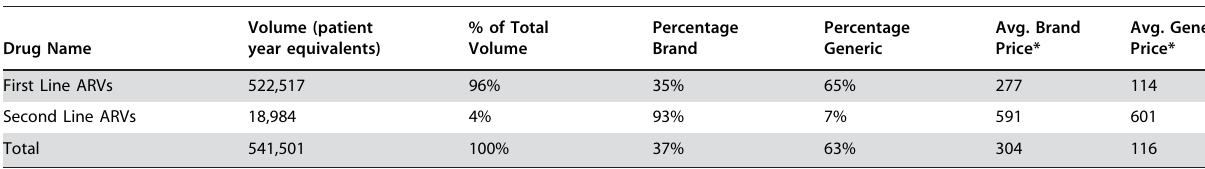
Table 1. First and Second Line Antiretroviral Drugs Procured for Sub-Saharan Africa .. ... .... ... ... .... ... ... .... ... ... .... ... ... .... ... ... .... ... ... .... ... ... .... ... ... .... ... ... .... ... ... .... ... ... .... ... ... .... ... ... .... ... ... .